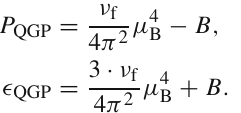
parameters, see the color code on the right side. The black and blue hor- izontal lines show the Stefan Boltzmann limit for two and three flavors